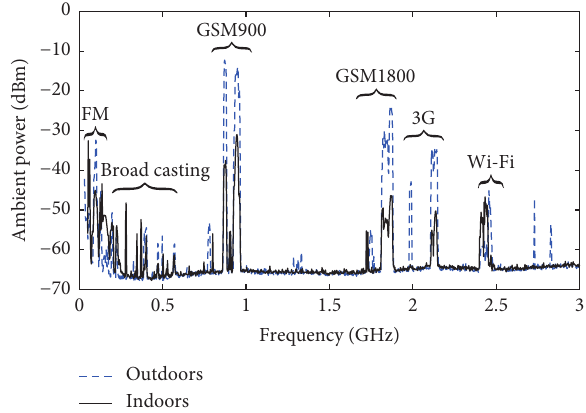
Figure 6: Peak ambient power vs. frequency in a semiurban